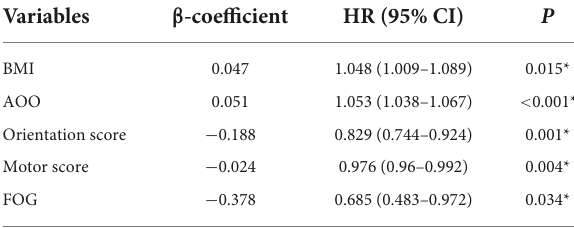
TABLE 5 Multivariate Cox proportional risk regression